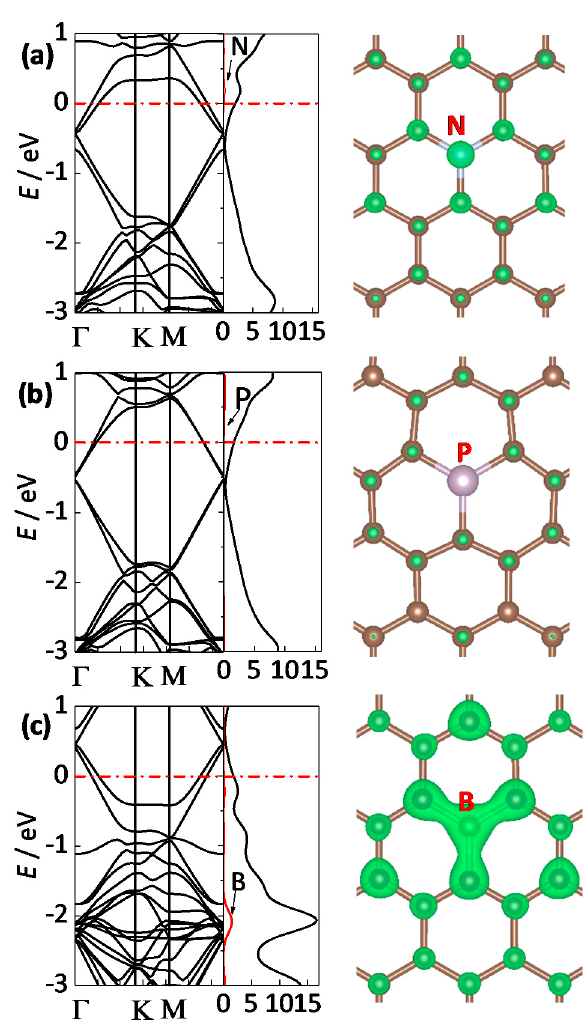
Figure 5. Band structure, density of states (DOS) and band-decomposed charge density (BDCD) iso-surface of ( a ) N-doped graphene (0.003 e/Bohr 3 ); ( b ) P-doped graphene (0.003 e/Bohr 3 ) and ( c ) B-doped graphene (0.006 e/Bohr 3 ).